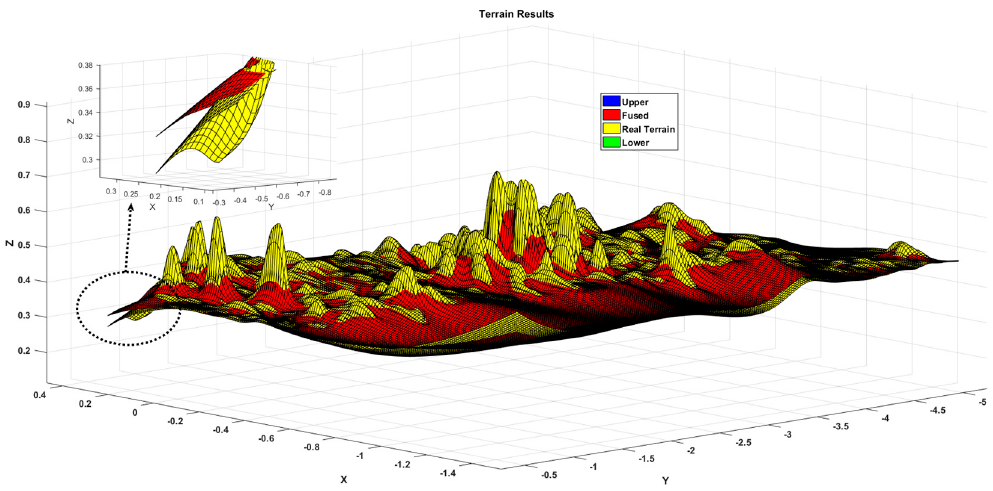
Figure 27. Comparative analysis of terrain estimates and real values.